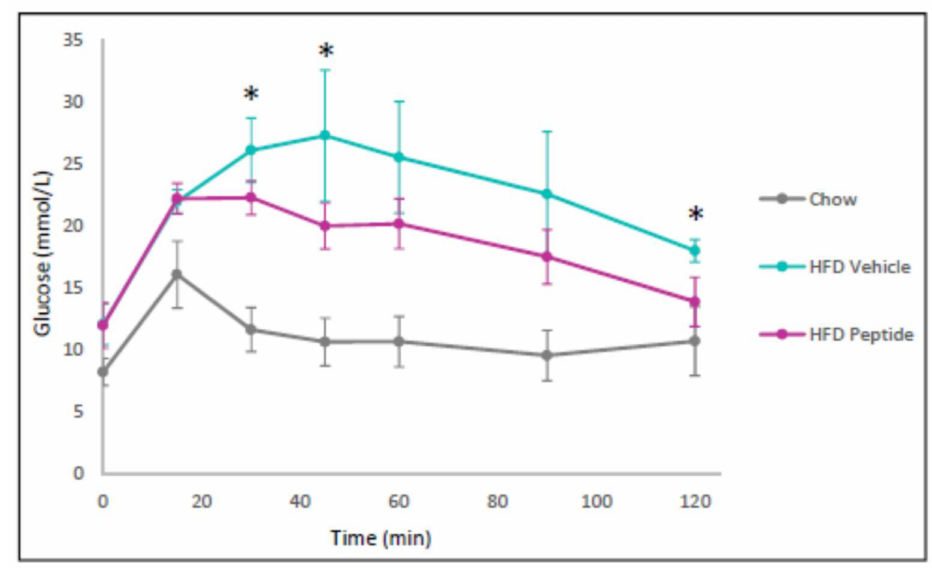
Figure 6. The TNFSF14 Peptide 7 reduces high fat diet-induced glucose intolerance. Mice were placed on a chow or a high fat diet (HFD) ( n = 4–5 mice/group). The HFD was administered for 10 weeks before Vehicle or Peptide 7 therapy (2.5 mg/kg). * p < 0.05 (HFD vehicle versus HFD peptide). Mean ±